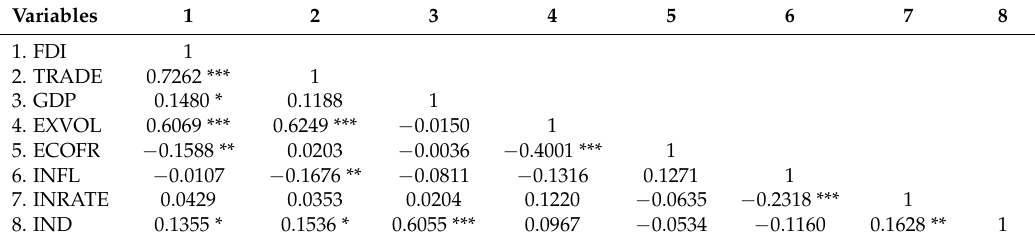
Table A2. Correlation Matrix with Exchange Rate Volatility (TGARCH).